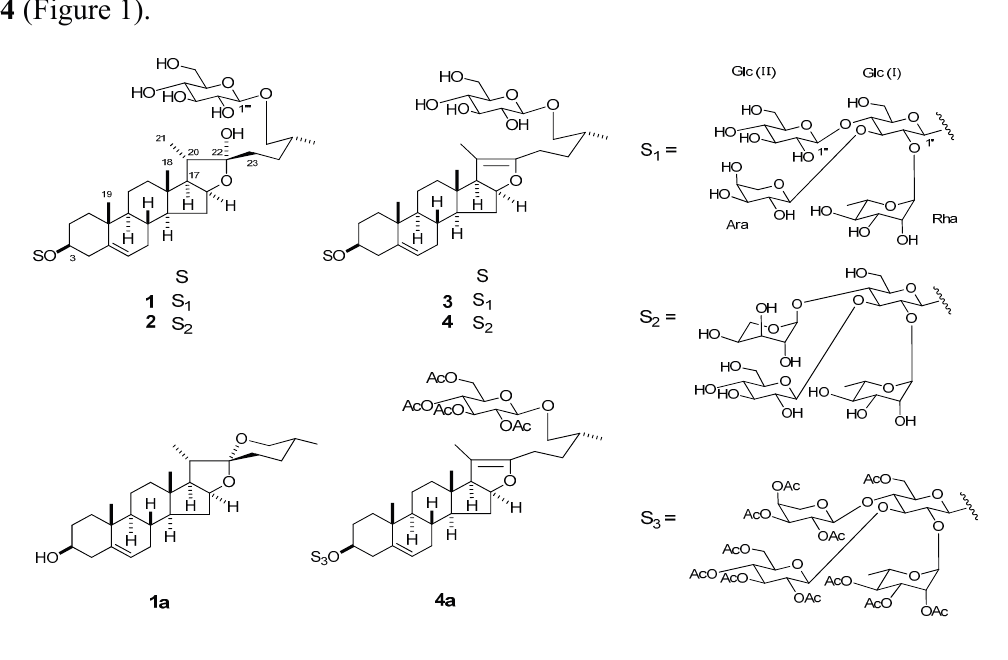
Figure 1. Steroidal glycosides from Lilium pumilum